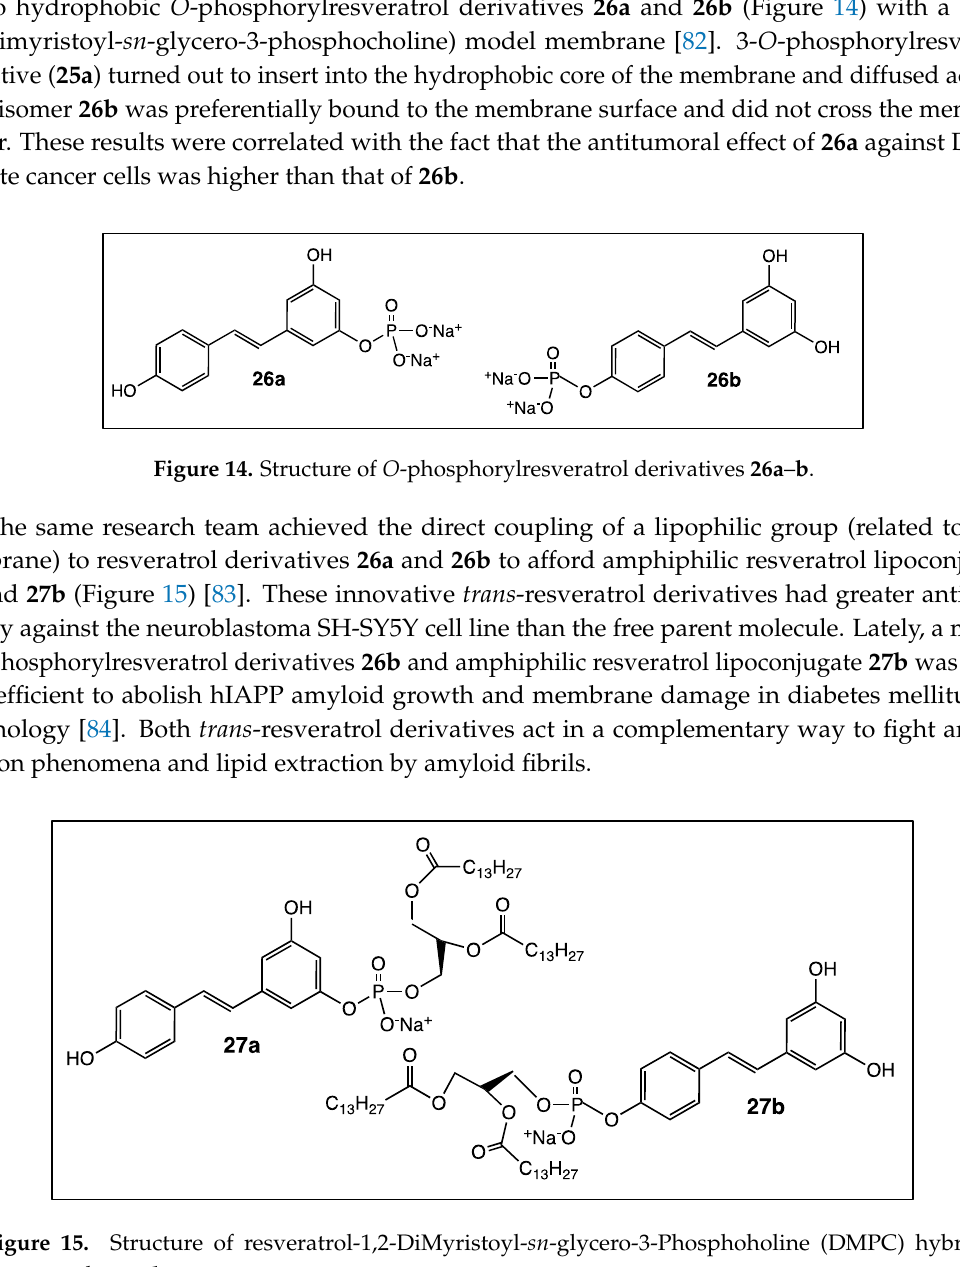
Figure 13 . Structure of ibuprofen ( 24 ) and resveratrol-ibuprofen hybrid compound 25.